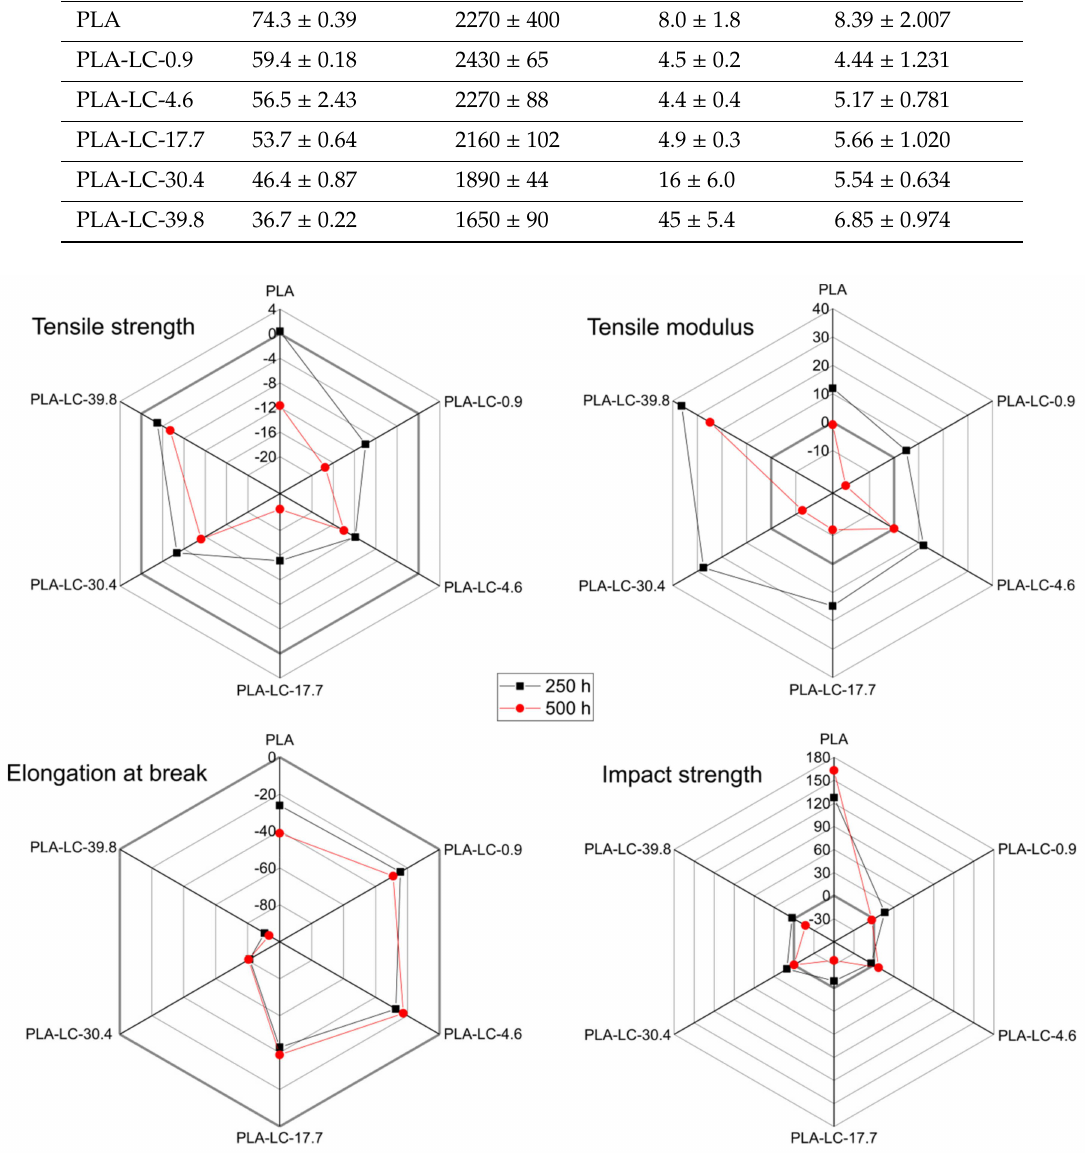
Figure 7. Relative change (in %) of the tensile strength, tensile modulus, elongation at break, and impact strength of the composite samples weathered for 250 and 500